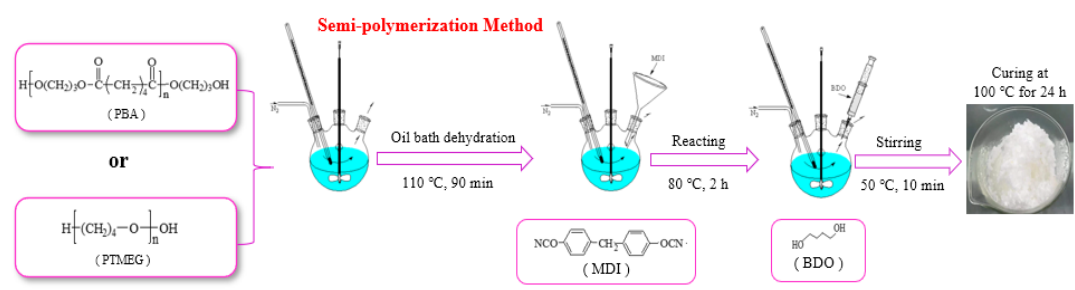
Figure 2. The preparation process of TPUs.